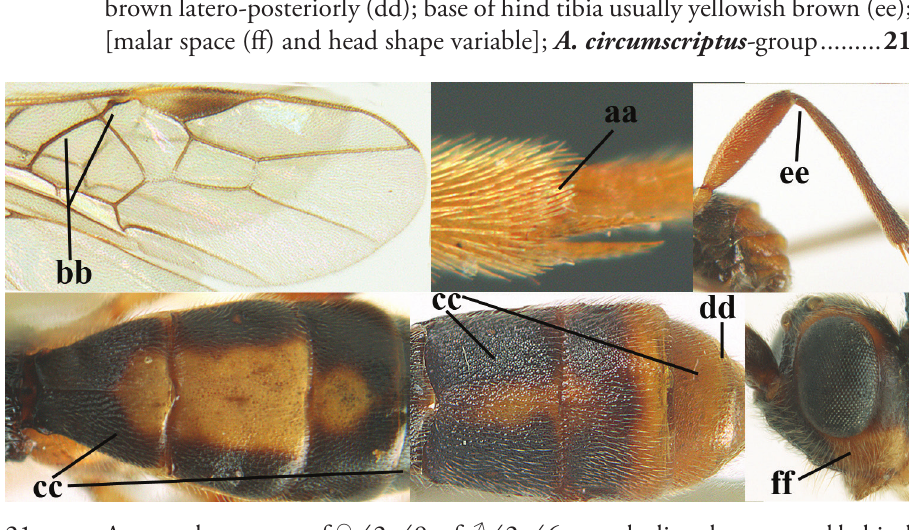
21 Antennal segments of ♀ 42–49, of ♂ 42–46; temple directly narrowed behind eyes in dorsal view (a), mesosoma black(ish) dorsally (especially mesoscutum and scutellum (b), but sometimes notaulic area or scutellum brownish) and apical half of metasoma largely blackish (c); hind femur usually orangeish brown (d); [second tergite with (pale) yellowish elliptical patch medially (e). If body pale yellowish, antenna with 47–51 segments, head coarsely sculp- tured dorsally and fourth and following tergites largely under enlarged and flattened third tergite (f), cf. A. hergeri Papp, 1989] ..................................